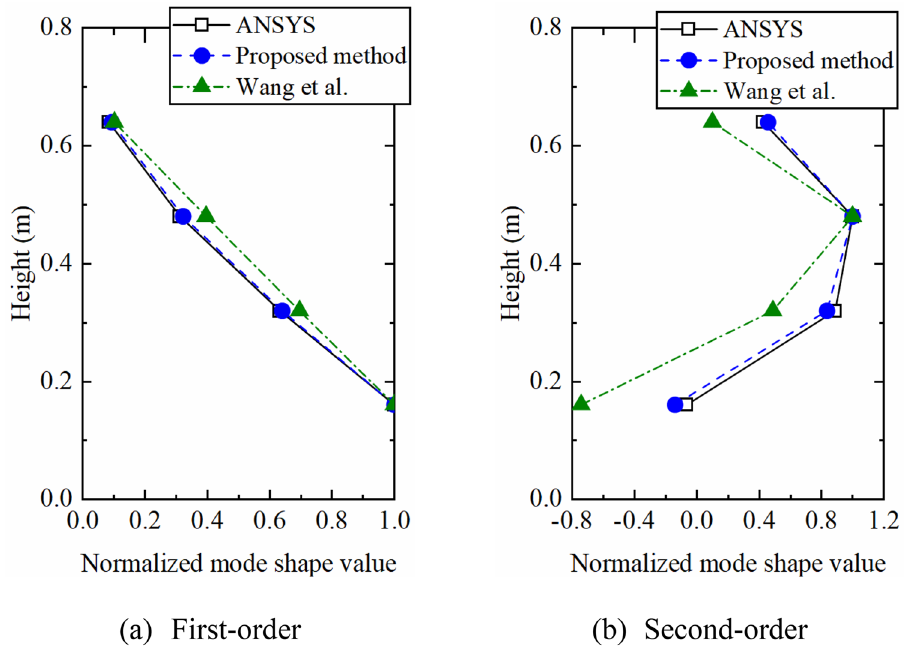
Figure 4. Strain mode shapes calculated by different methods.